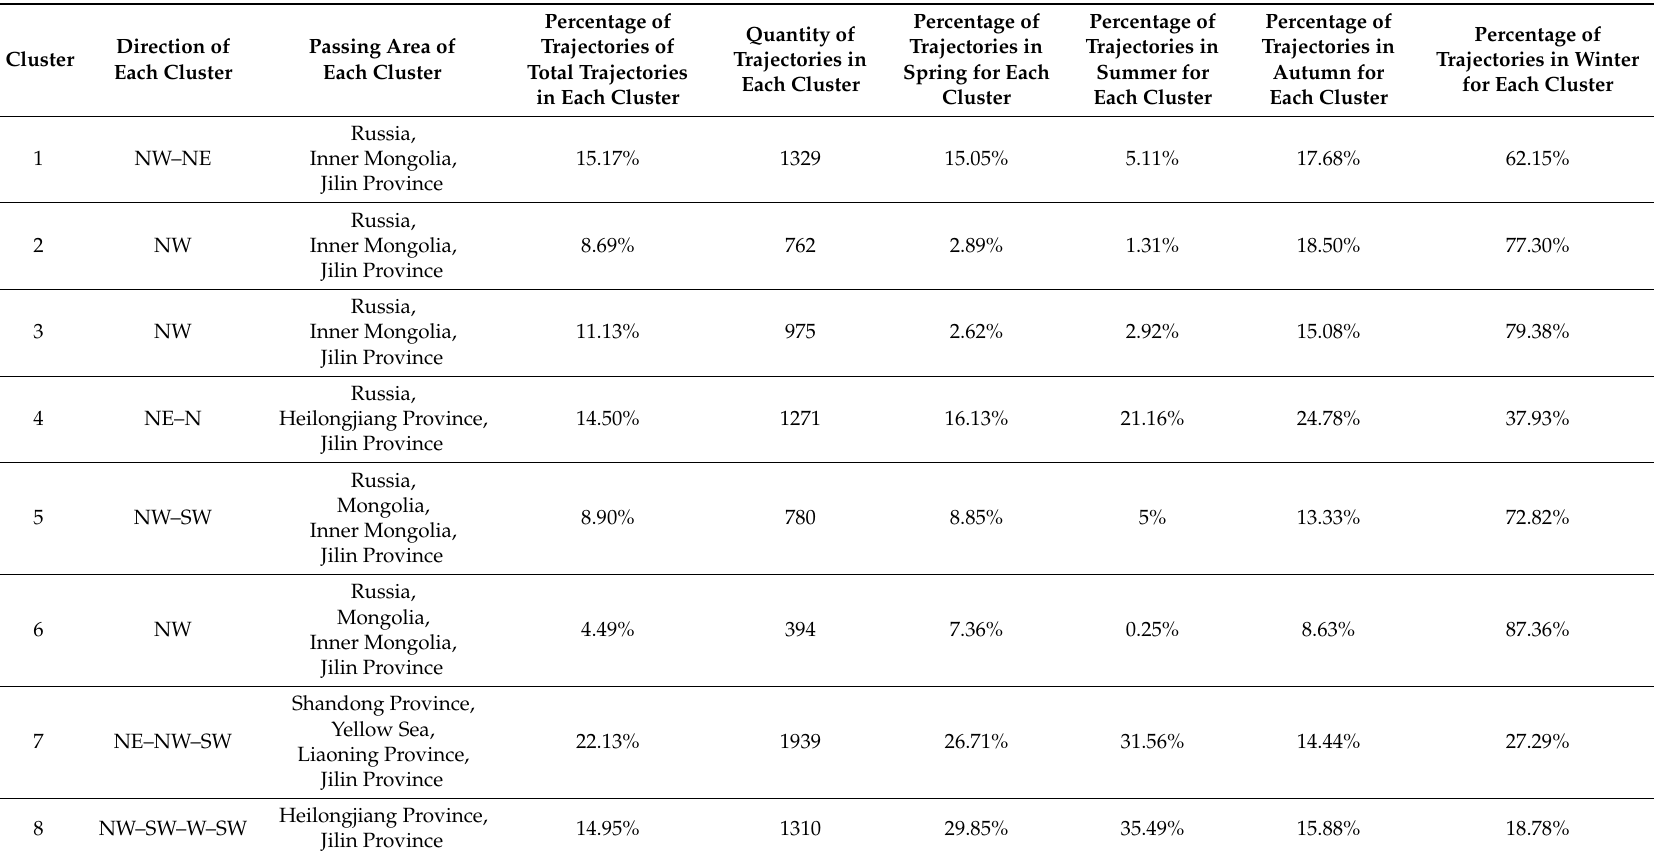
Table 2. Specific Information on Each Cluster in the Cluster